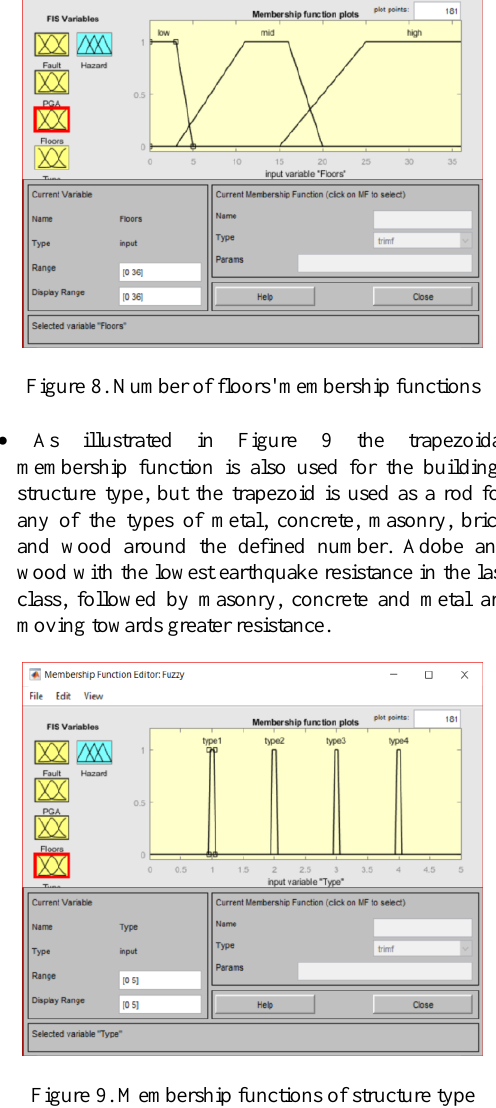
Figure 9. Membership functions of structure